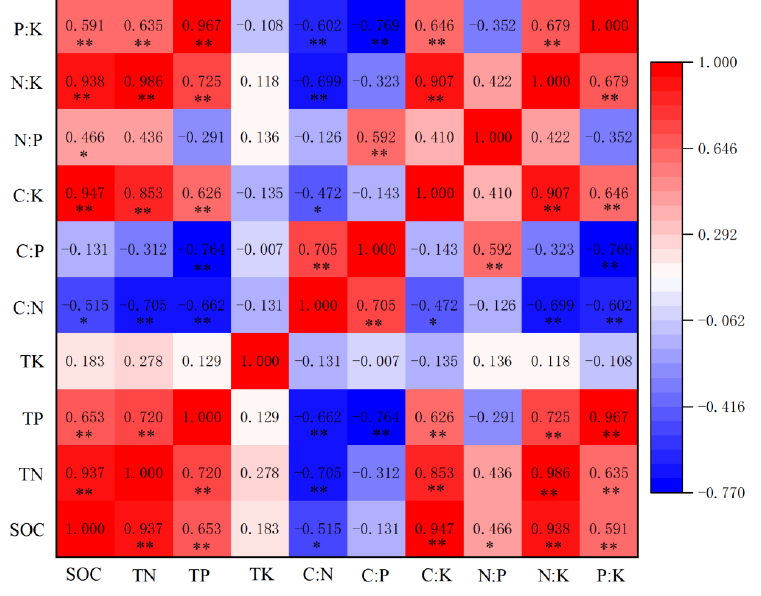
Figure 7. Pearson’s correlation heatmap of rhizosphere soil C, N, P, K concentrations and